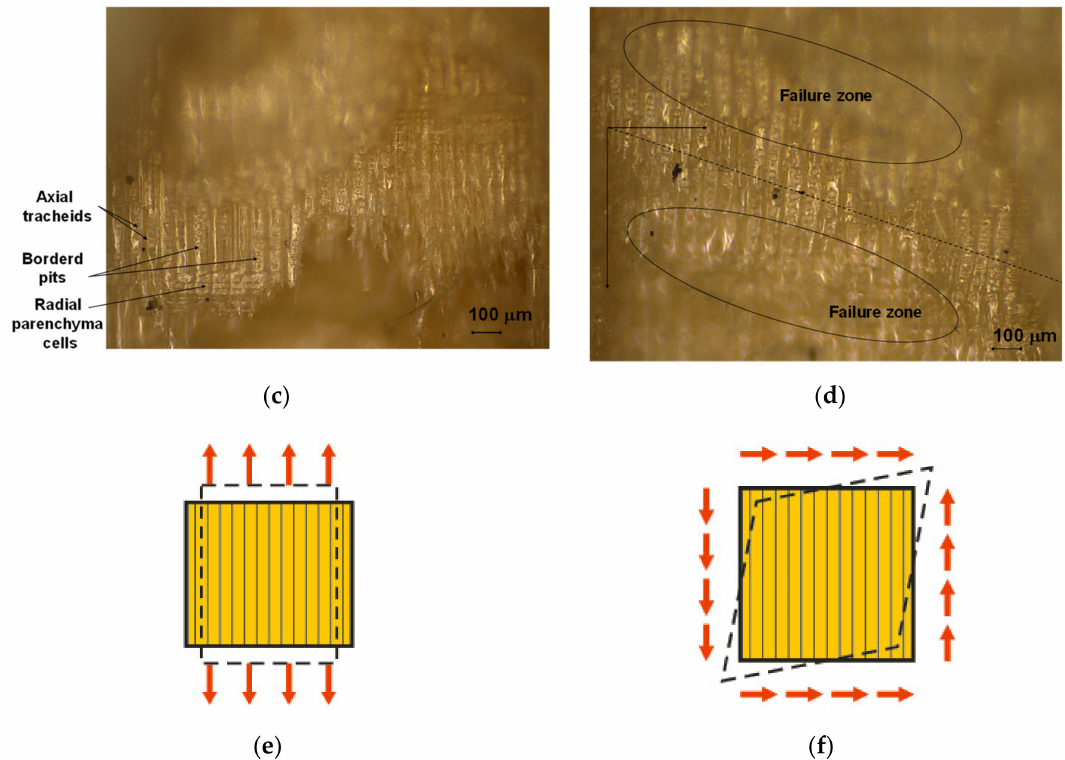
Figure 10. The structure of pine samples in di ff erent degradation stages: ( a ) initial macros-structure of wood samples, before test; ( b ) optical view of wood fracture after test; ( c ) microscopic view of tracheid cells failure, magnification × 100; ( d ) failure trend line, magnification × 100; ( e ) schematic representation of traction deformation; ( f ) schematic representation of wood failure due to